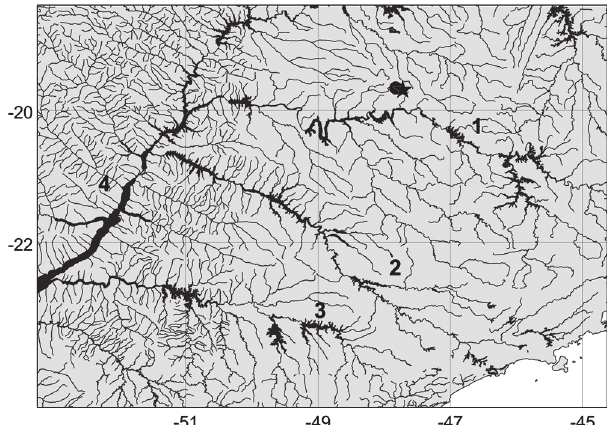
Fig. 4. Southeastern Brazil showing geographic distribution of Microlepidogaster dimorpha in rio Grande drainage (1 - rio Grande; 2 - rio Tietê; 3 - rio Paranapanema; 4 - rio Paraná). Star designates the type